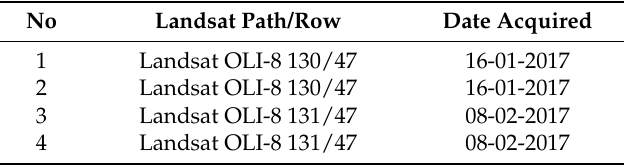
Table 1. Specifications of Operational Land Imager-8 (OLI) imagery used in this study.